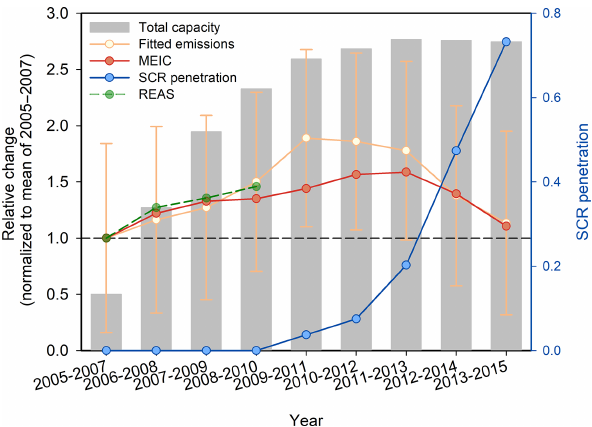
Figure 7. Interannual trends of the fitted (red line) and bottom-up NO x emissions for selected power plants during 2005 to 2015. The emissions deriving from the MEIC and REAS v2.1 inventory are displayed in pink and green, respectively. The bar denotes the total capacity of selected power plants. The blue line denotes the pene- tration of power plants with denitration devices (defined as the per- centage of unit capacity of power plants installing SCR in the total capacity of all the power plants). Error bars show the uncertainties for fitted emissions by this method (see Sect.